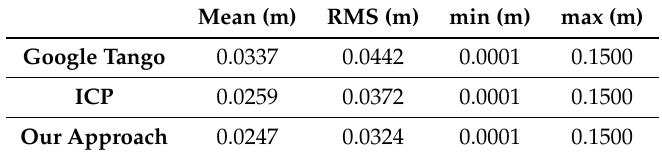
Table 2. Hausdorff distance from the MeetingRoom dataset to the FARO laser scanned point